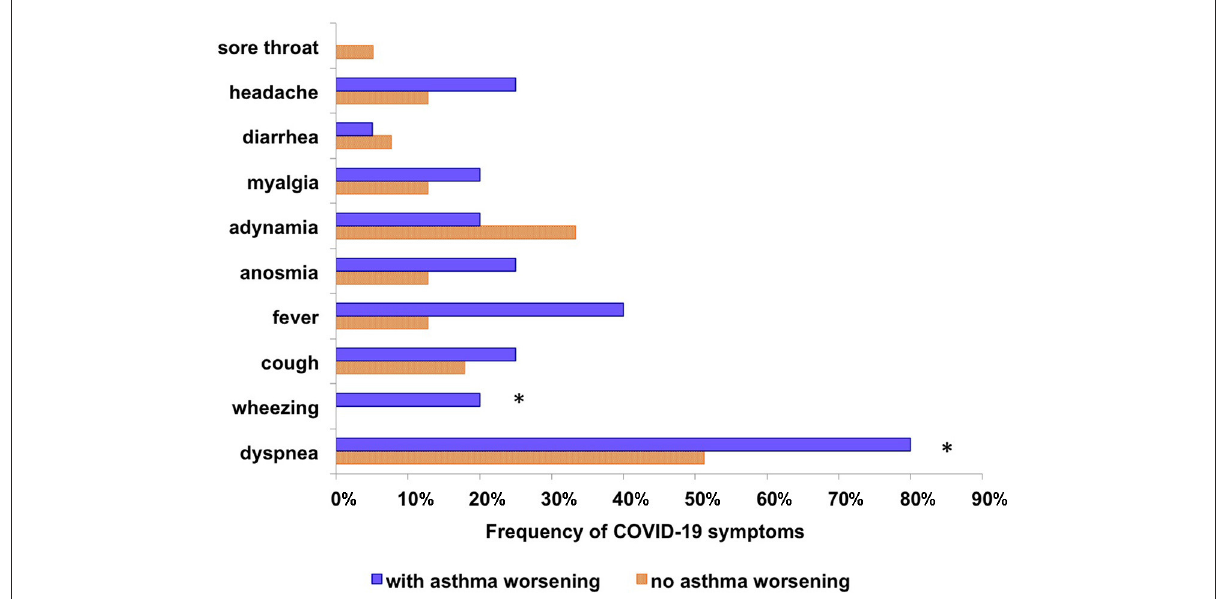
FIGURE2 Comparison of the frequency of acute symptoms of COVID-19 between asthmatics with post-COVID-19 respiratory symptoms and asthmatics without post-COVID-19 respiratory symptoms. * p < 0.05, *Chi-square test.